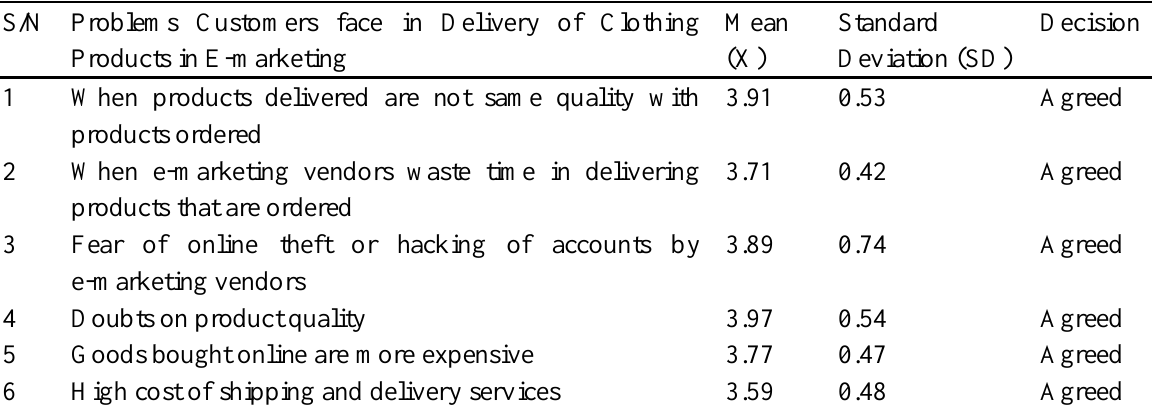
Table 4: Mean Rating and Standard Deviation Responses of the Problems Customers Face in Delivery of Clothing Products in